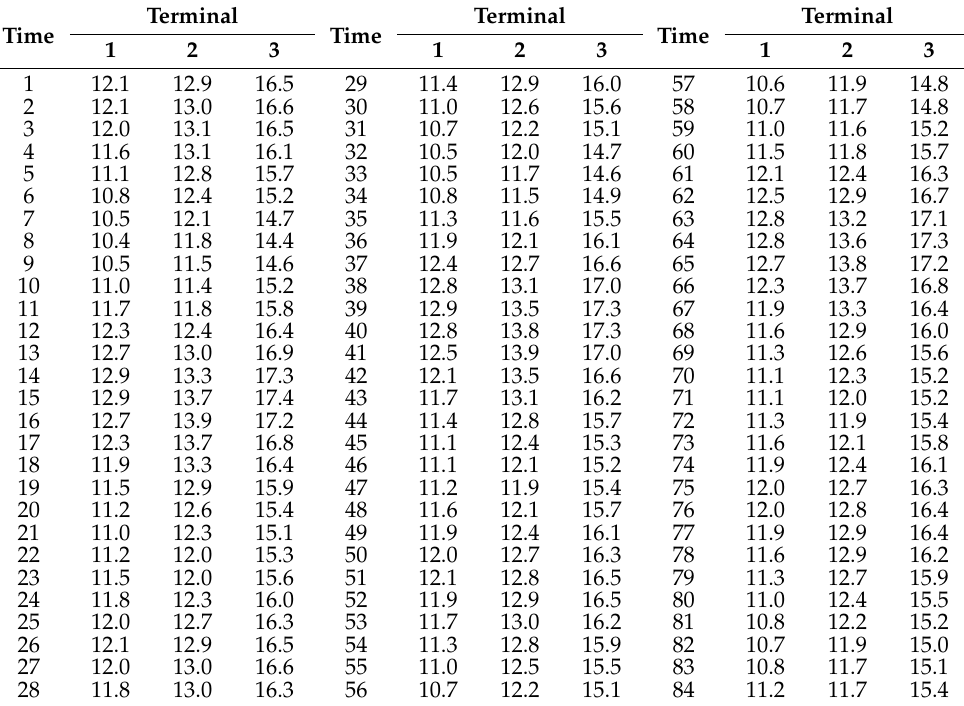
Table 3. Water depth for each terminal influenced by tides